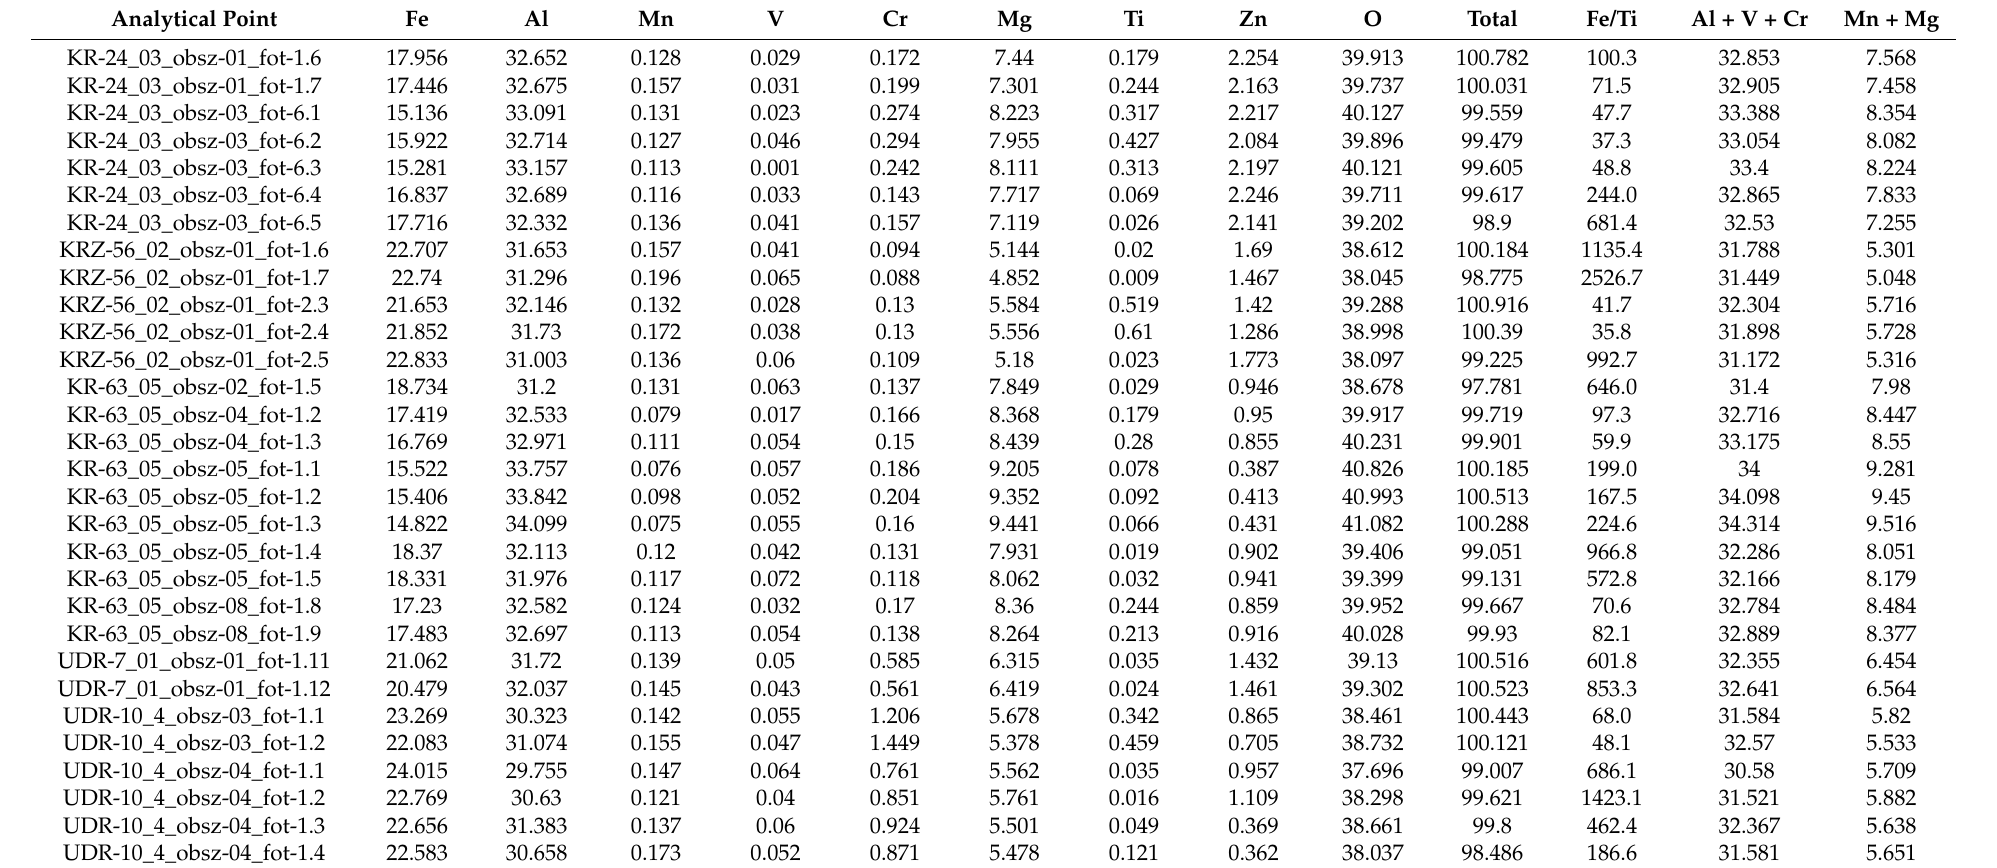
Table A3. Chemical composition of Al-spinels from the Krzemianka and Udryn Fe-Ti-V deposits in NE Poland identified via